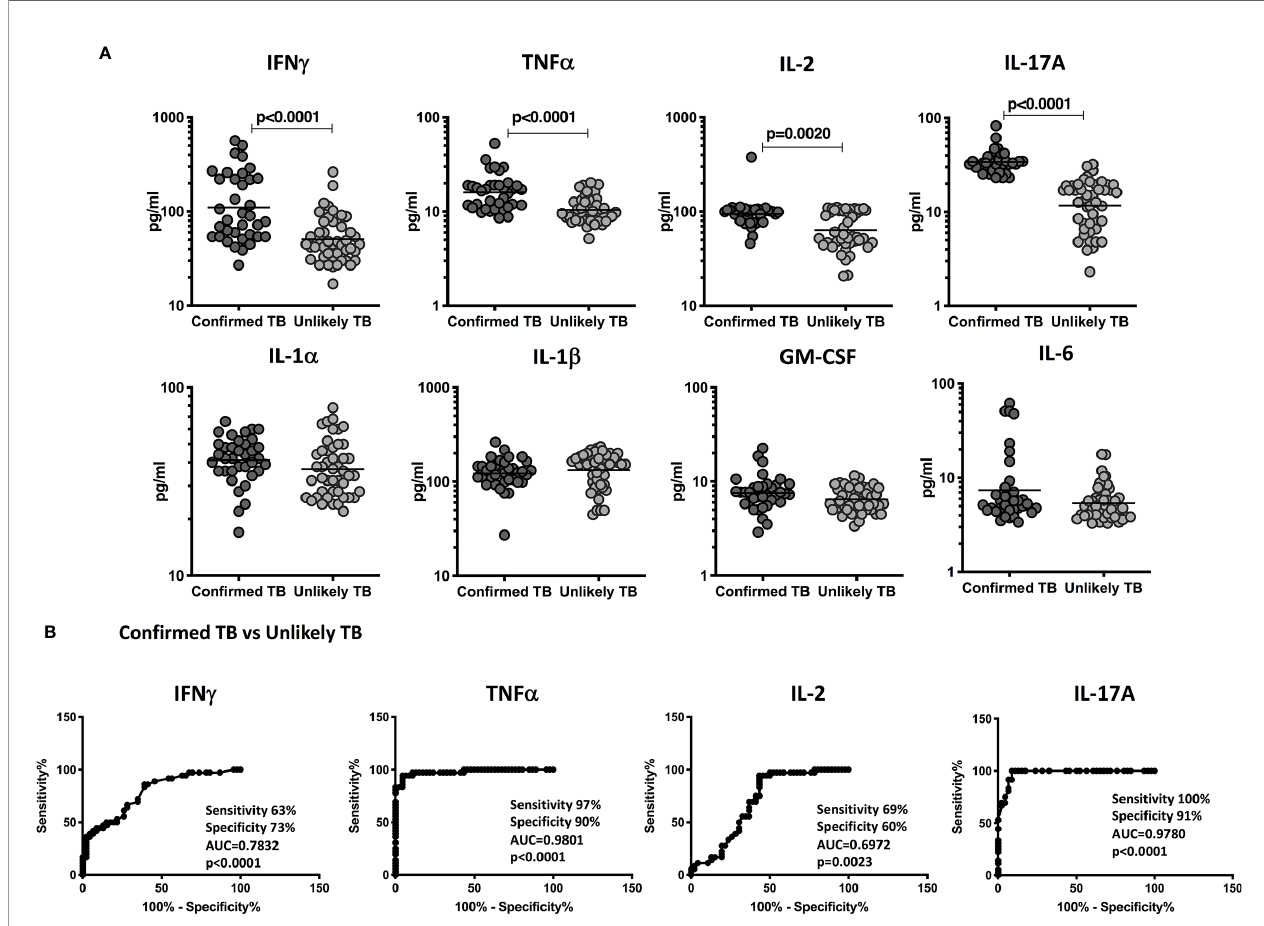
FIGURE 4 | Elevated circulating levels of Type1 and Type 17 cytokines in children with con fi rmed TB disease and ROC analysis to estimate the discriminatory power of plasma Type 1 and Type 17 cytokines in children with con fi rmed TB disease and unlikely TB – Validation cohort. (A) The plasma levels of IFN g , TNF a , IL-2, and IL-17A (B) IL-1 a , IL-1 b , GM-CSF, and IL-6 and were measured in con fi rmed TB (n=36) and unlikely TB (n=46) individuals at baseline. (B) ROC analysis to estimate the sensitivity, speci fi city and AUC was performed using IFN g , TNF a , IL-2, and IL-17A to estimate the capacity of these factors to distinguish individuals with con fi rmed TB vs. unlikely TB. The data are represented as scatter plots with each circle representing a single individual. P values were calculated using the Mann- Whitney test with Holm ’ s correction for multiple